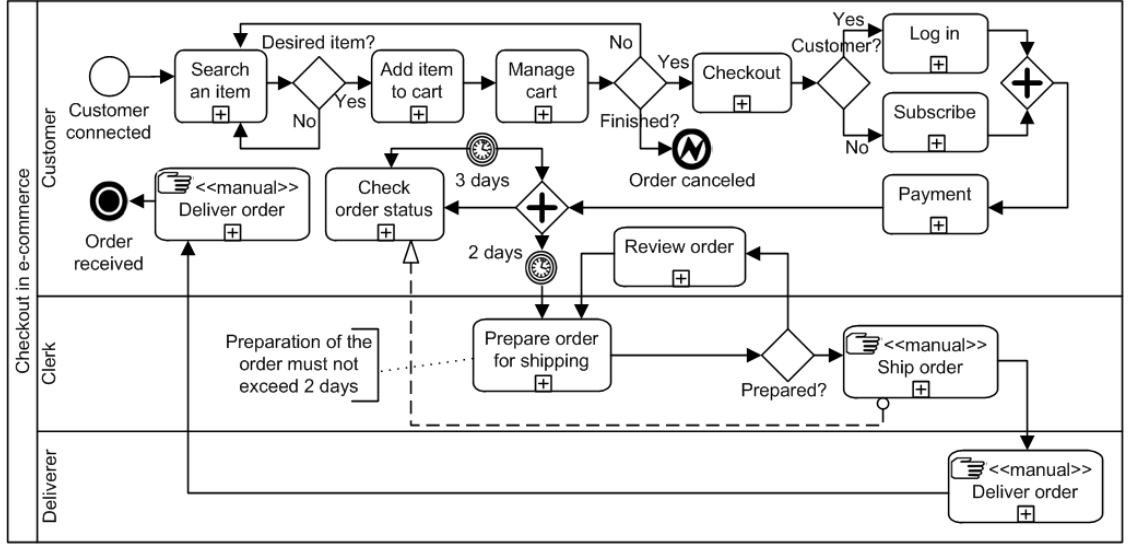
Fig. 2. BPMN business process model on high abstraction level, adapted from [17].